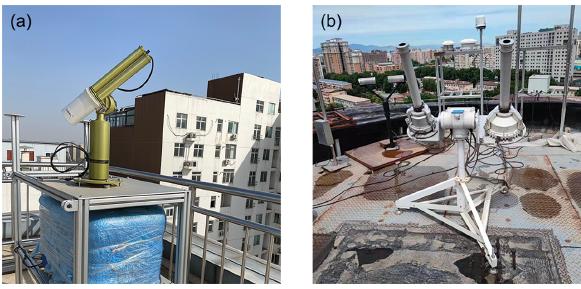
Figure 1. The CE-318 sun photometer (a) and EKO spectrora- diometers (b)